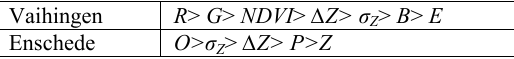
Figure 3: Feature relevance of dataset Enschede.